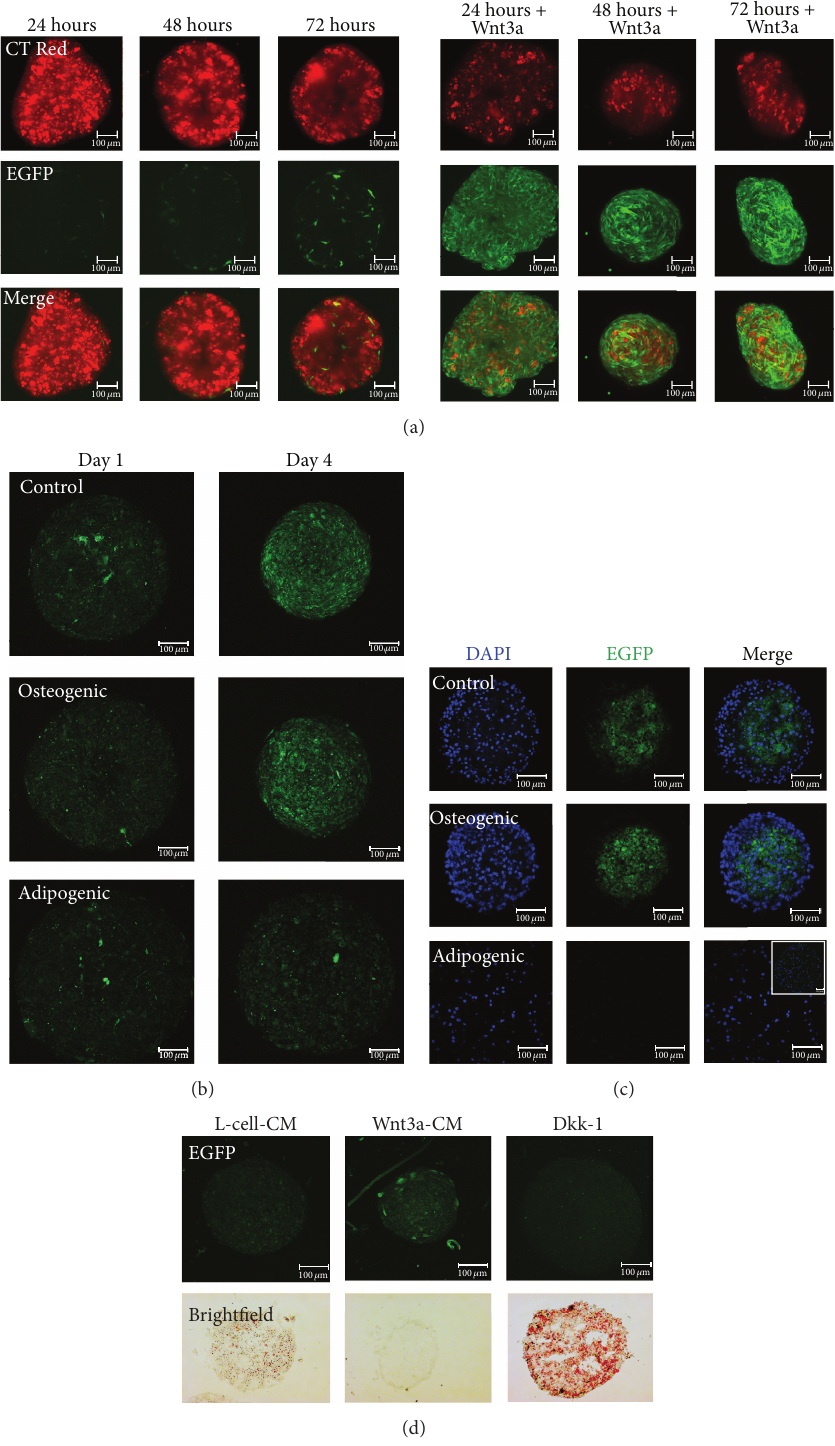
Figure 3: Wnt pathway activation is observed reproducibly in 3D MSC culture and during osteogenic differentiation but not during adipogenic differentiation. (a) Lightsheet microscopy of cell tracker red stained human Y201 Wnt EGFP MSCs showing sporadic activation of Wnt signalling increasing with time in culture, with Wnt3a-treated controls (right panels). Scale bar = 100 𝜇 m. (b) Confocal microscopy of murine C3H10T1/2 MSC 3D cultures showing Wnt signalling is active in basal conditions and during osteogenic differentiation but not adipogenic differentiation. Scale bar = 100 𝜇 m. (c) Immunofluorescence of sectioned spheroids stained for EGFP demonstrates location of EGFP fluorescence in 3D culture. Scale bar = 100 𝜇 m. Adipogenic differentiation causes spheroids to enlarge in size; a lower magnification image of the whole spheroid is included (top right, merge panel). (d) Adipogenic C3H10T1/2 MSC spheroids show inverse relationship between adipogenesis and Wnt signalling by Oil Red O